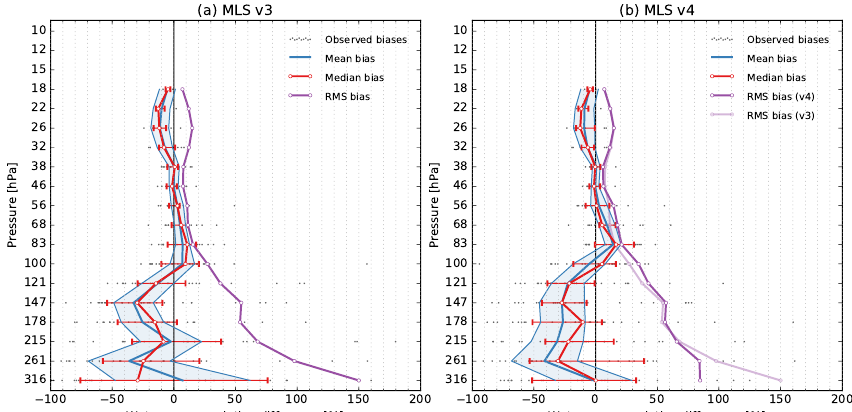
Figure 8. As in Fig. 4, but for relative biases between CFH and (a) MLS v3 and (b) MLS v4 profiles of water vapour volume mixing ratio. The mean and rms biases (and associated uncertainties) are calculated from absolute differences and then normalized relative to the mean CFH-derived mixing ratio at each level. The median bias and IQR are calculated using relative differences from each validation profile.